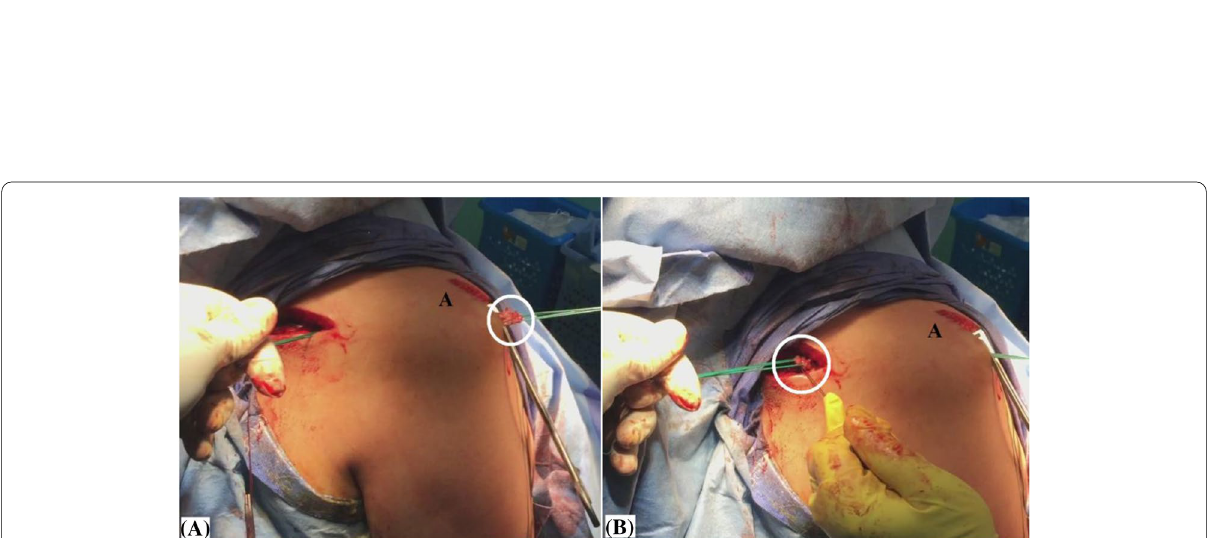
Fig. 9 A, B demonstrate checking of adequate length of the hamstring sheet (marked in white circle) for future re‑attachment in currently − reported technique of middle trapezius tendon transfer in the right shoulder; A, on the humeral side; B, on the scapular side; A,